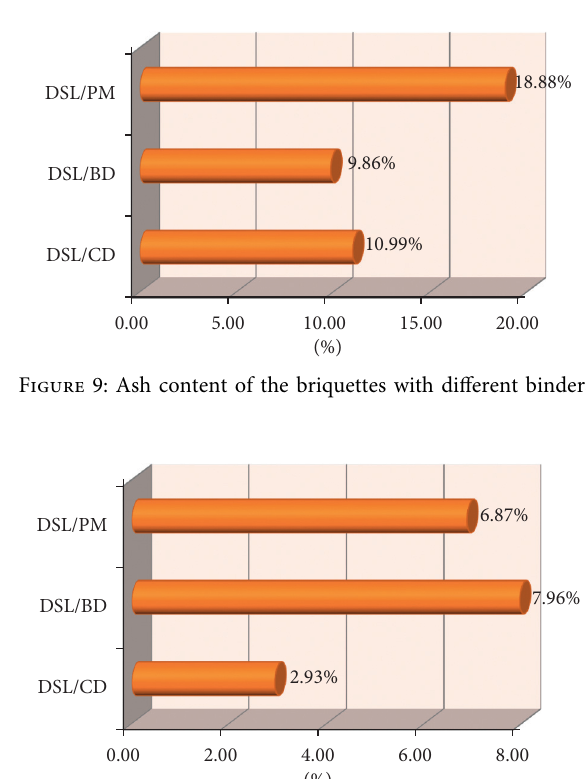
Figure 11: Volatile matter content of the briquettes with different binders.